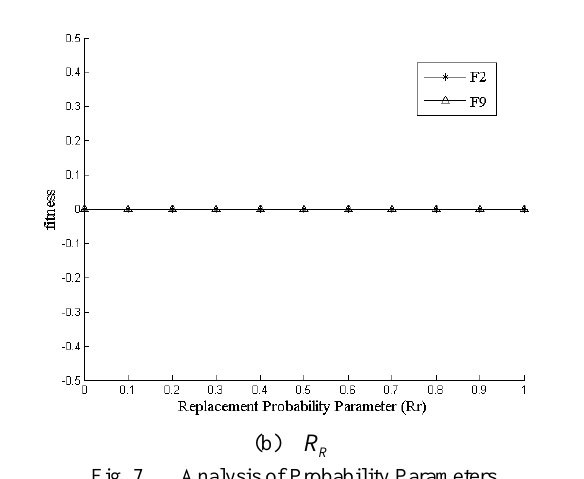
Fig. 7 Analysis of Probability Parameters